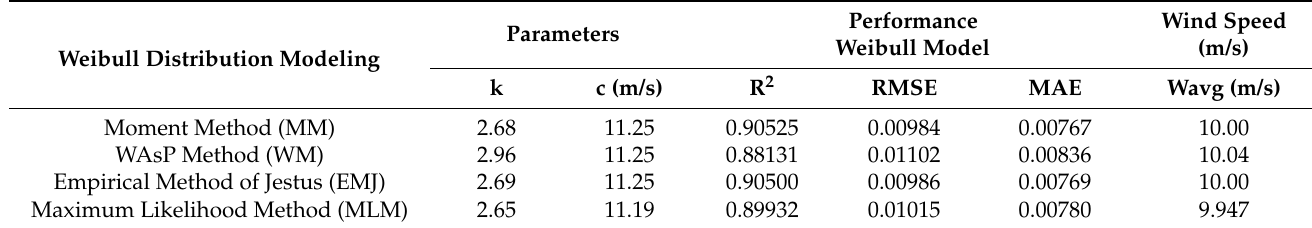
Table 1. Result of Weibull parameters at level of 80 m of